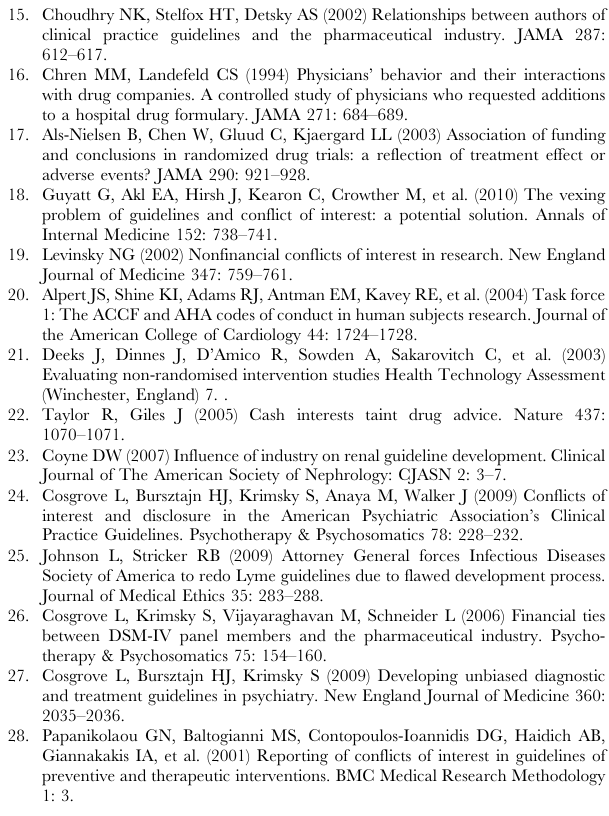
Figure S1 PRISMA flow diagram 1980 to March, Week 4, 2011. Table S1 Search strategy. Ovid MEDLINE and Ovid OLD- (DOCX) Table S2 Results of included studies. Abbreviations: CI, confidence interval; COI, conflict of interest; CPG(s), clinical practice guideline(s); ESP, erythropoietin-stimulating protein; NR, not reported; No., number; OR, odds ratio.